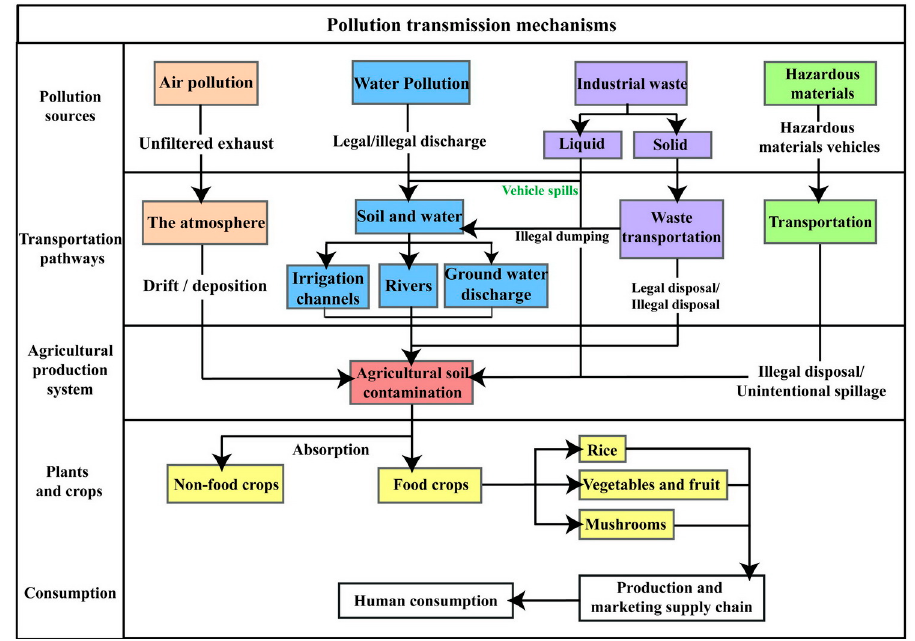
Figure 1. Pollution transmission mechanisms in agricultural environments in Taiwan.